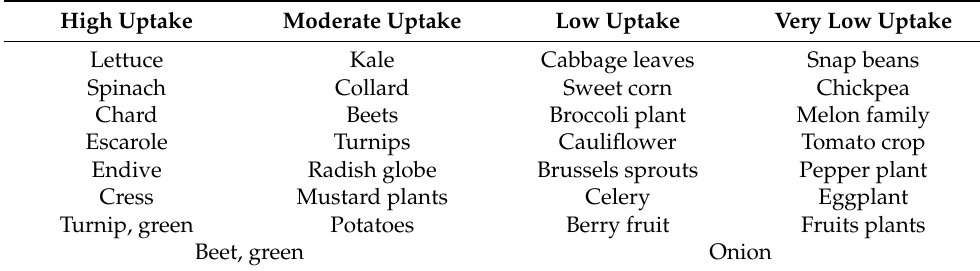
Table 12. Accumulation of cadmium (Cd) levels exposed to edible crops in various vegetables